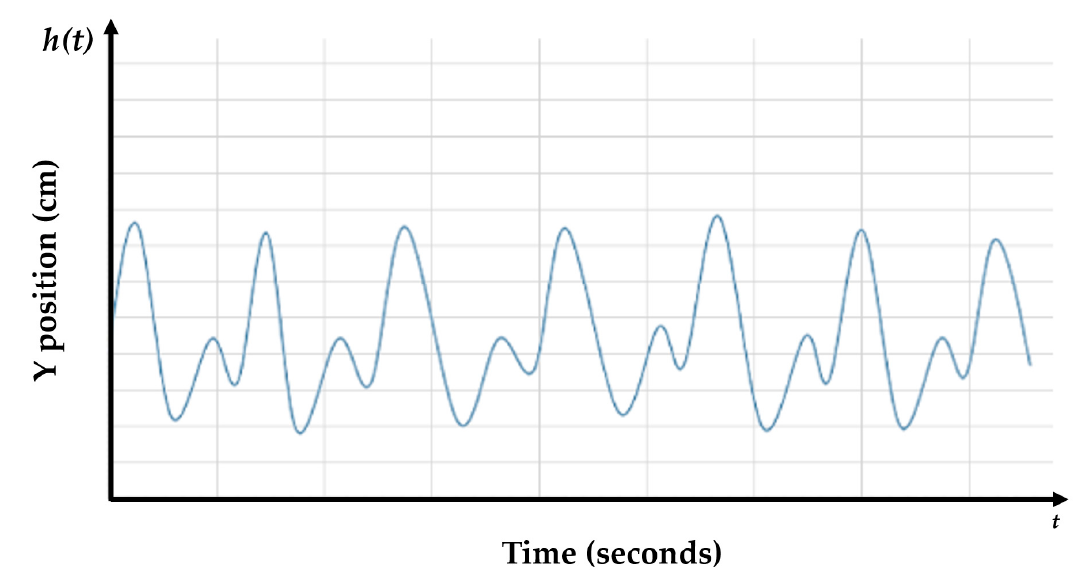
Figure 5. Simplified graph of the height of the palm position during a duple gesture.